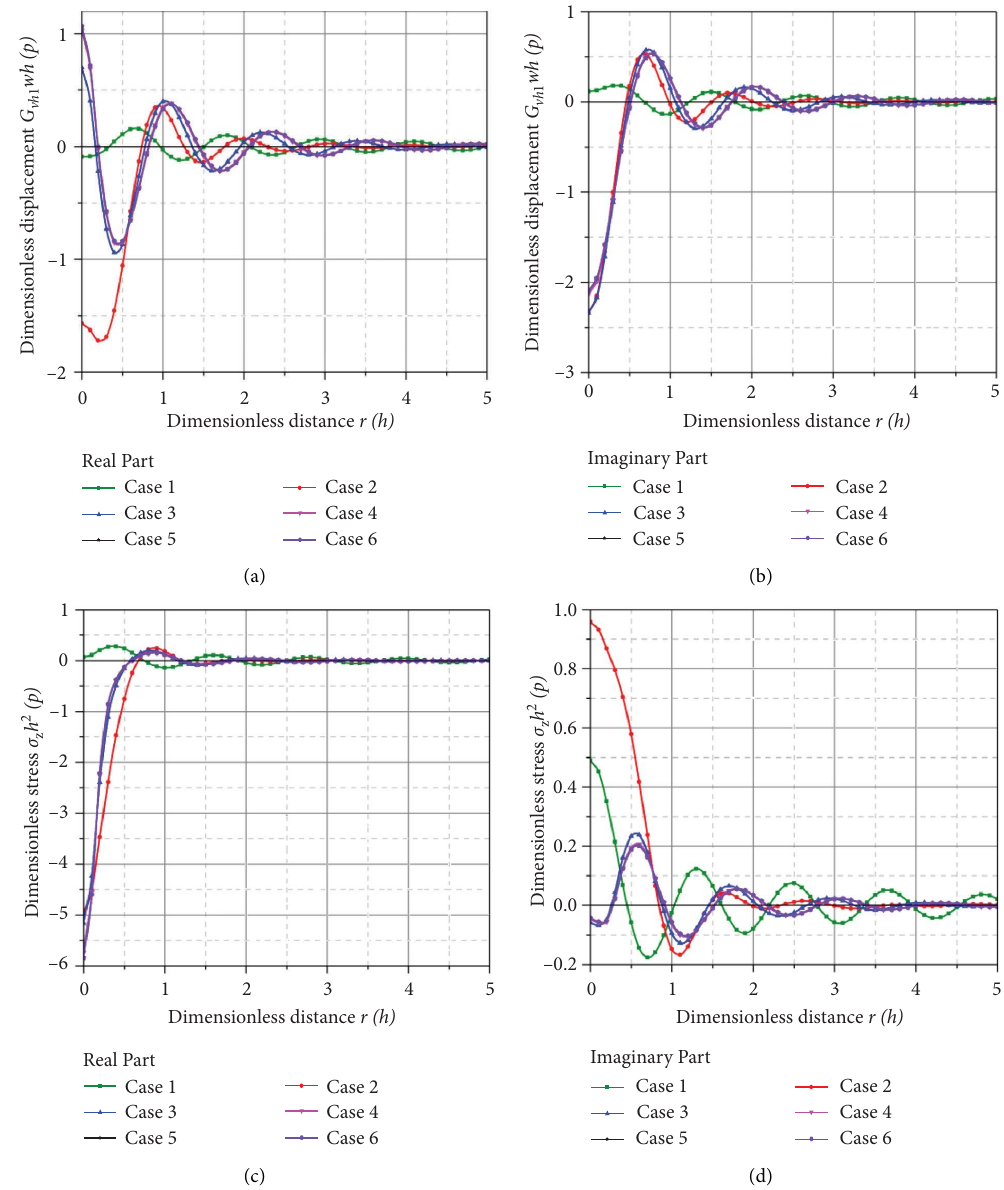
Figure 9: Te vertical displacement and the vertical stress of the medium versus the dimensionless distance for the diferent cases at a fxed dimensionless frequency of two ( ω 0 � 2) and a depth of 0.15 m ( z � 0.15m): (a) and (c) are the variation of the real parts; (b) and (d) are the variation of the imaginary